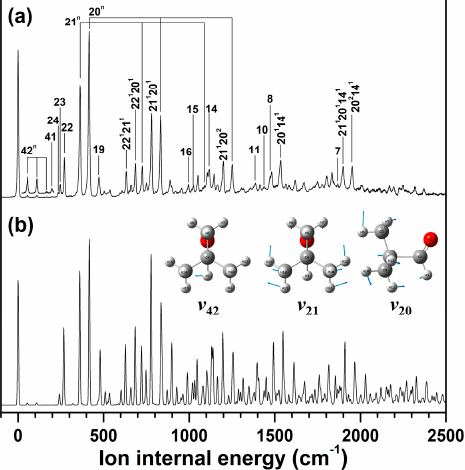
ure 5a). As such, the simulated spectrum was comparable to the VUV-MATI spectrum in quantitative terms, implying that the cationic eclipsed conformer can be induced by the electron removal from the HOMO of the neutral gauche conformer.